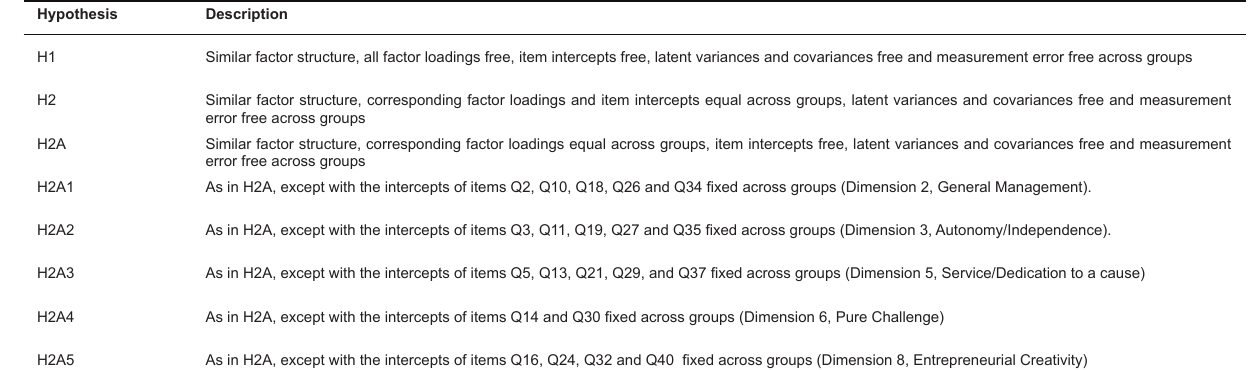
TABLE 7 Hierarchical hypotheses and partial invariance hypotheses used for invariance testing